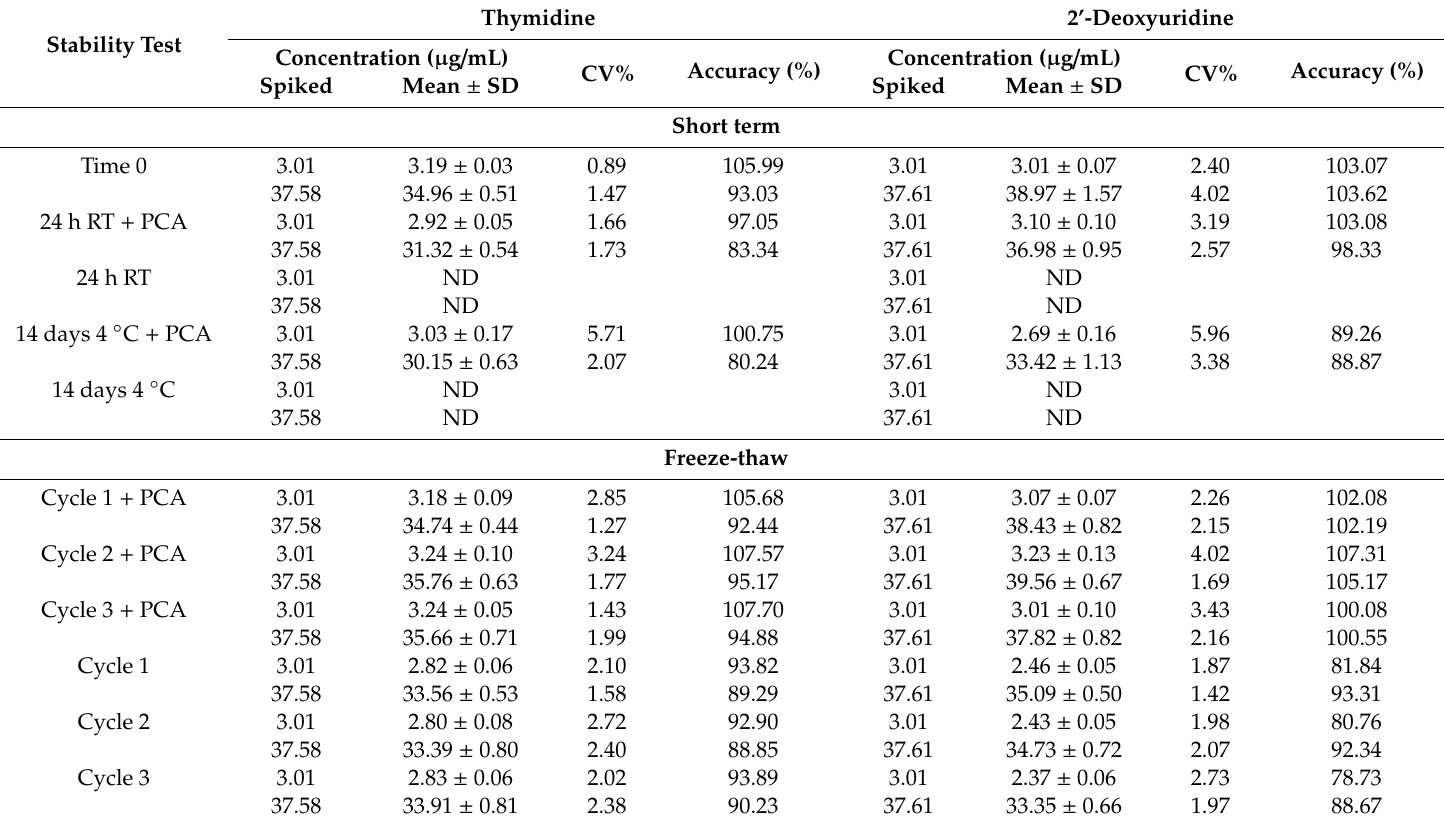
Table 4. Stability testing of thymidine and 2’-deoxyuridine in